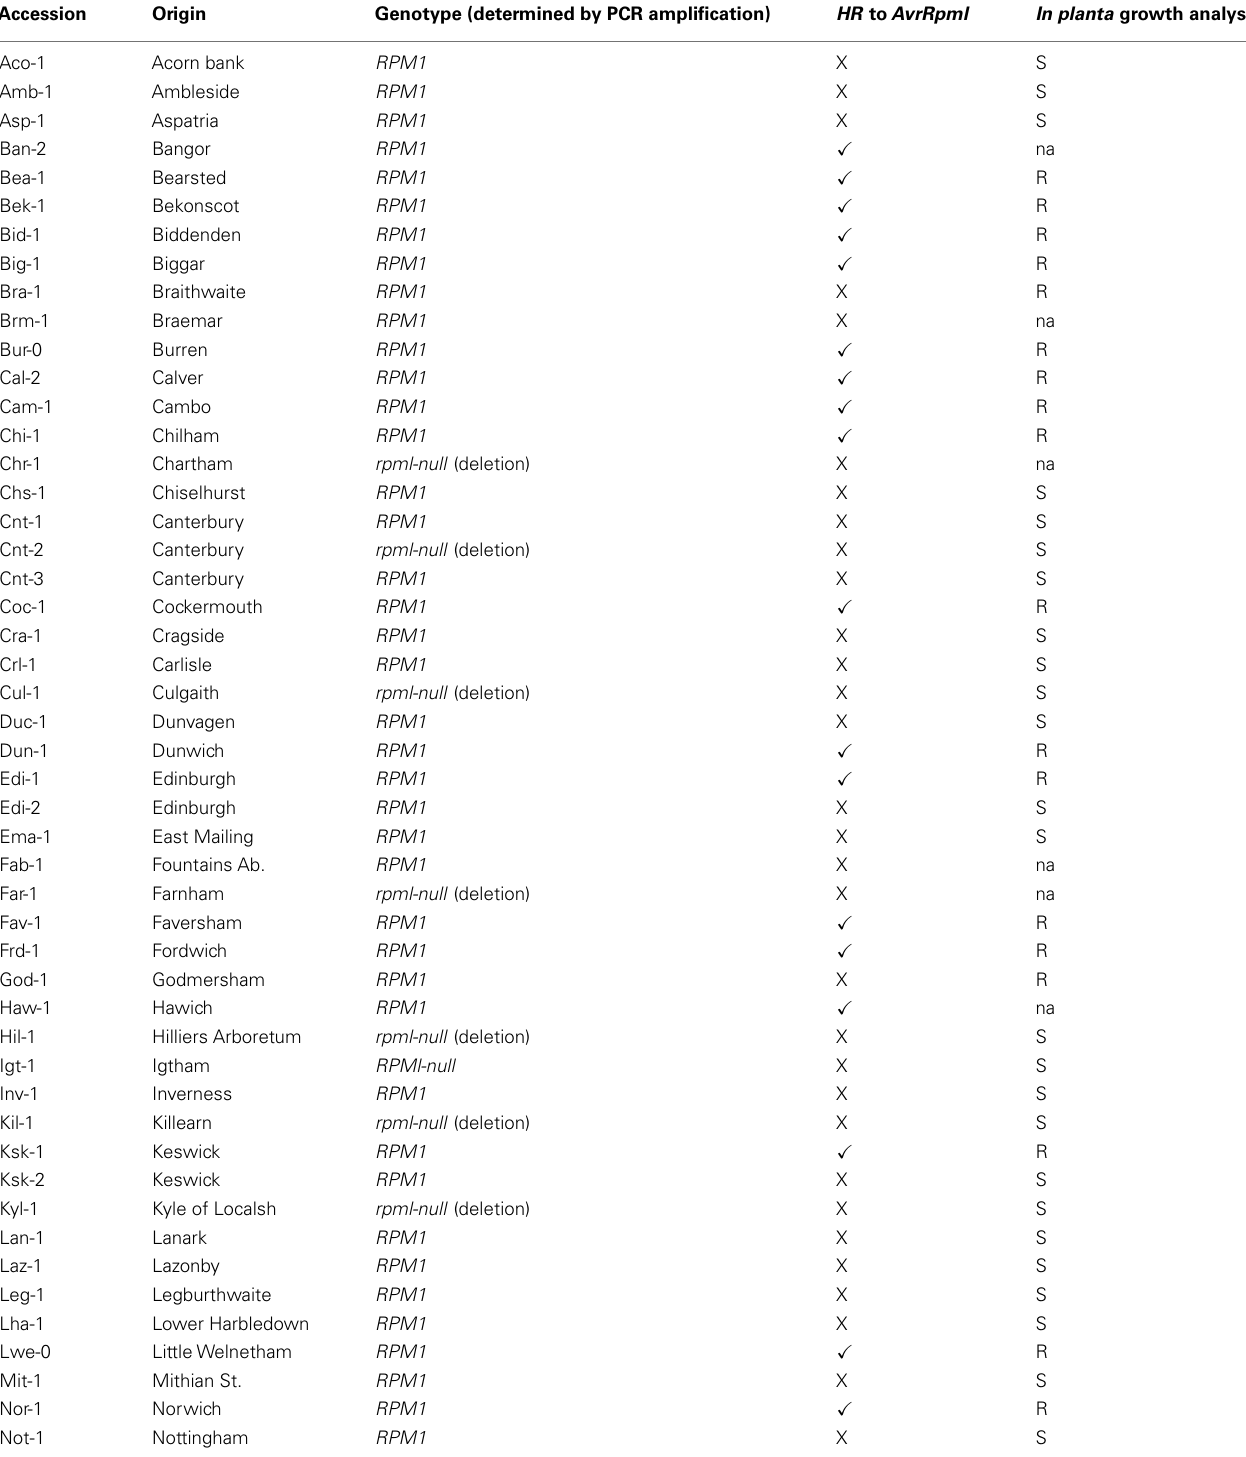
TableA1 | RPM1 genotypes and resistance phenotypes across UK